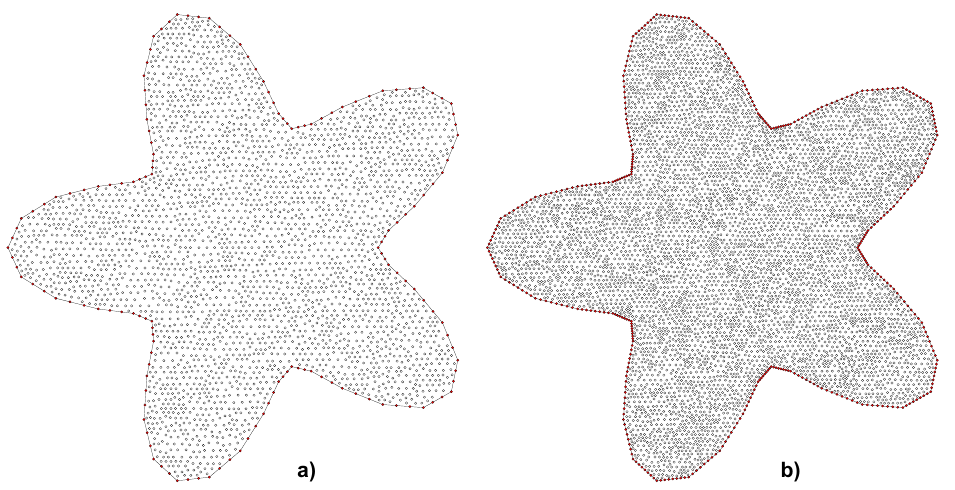
Figure 6. Example No. 2—irregular meshes: ( a ) 3216 points, ( b ) 6530 points. The dispersion and decay coefficients are D = 5 and λ = 4, respectively. The vector of (cid:0) (cid:1) = ( v x , v y velocity is constant, v = 1, 1 ) . Dirichlet boundary conditions are prescribed at the boundary Γ as